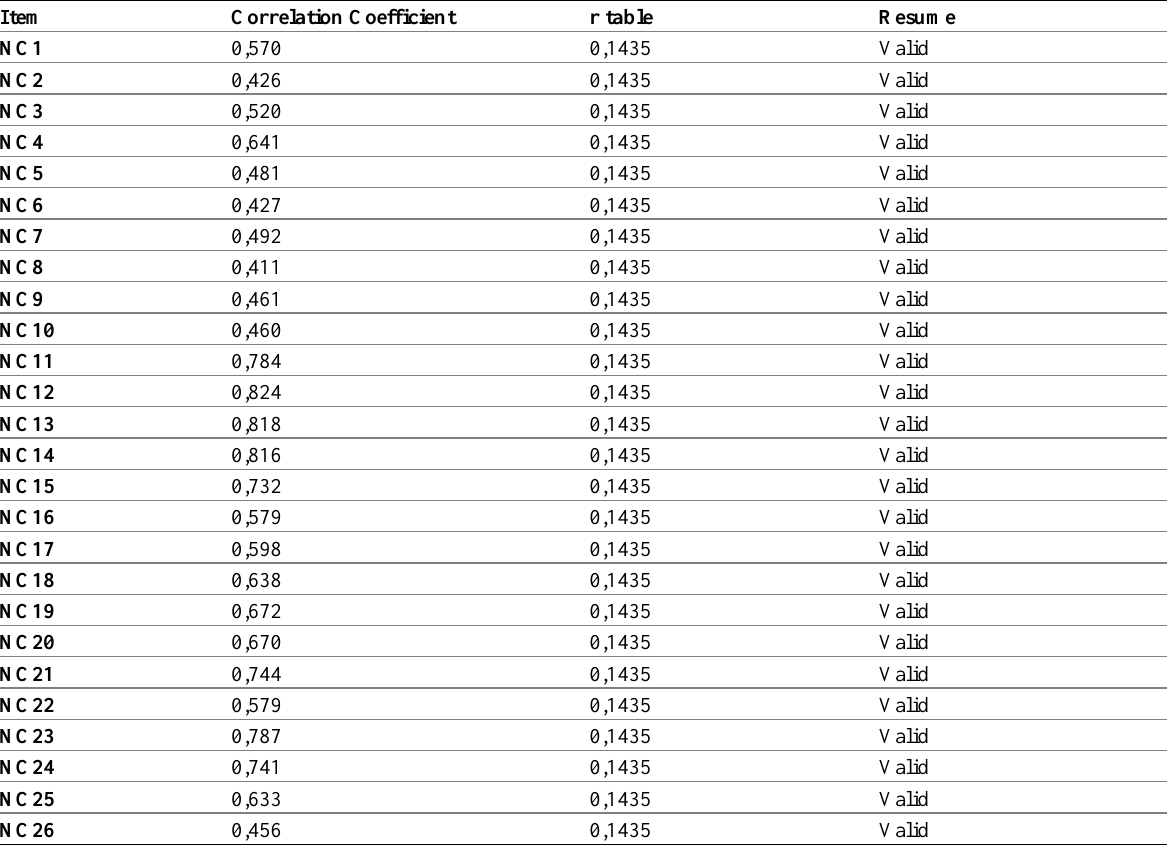
Table 1: Networking Capability Validity Test